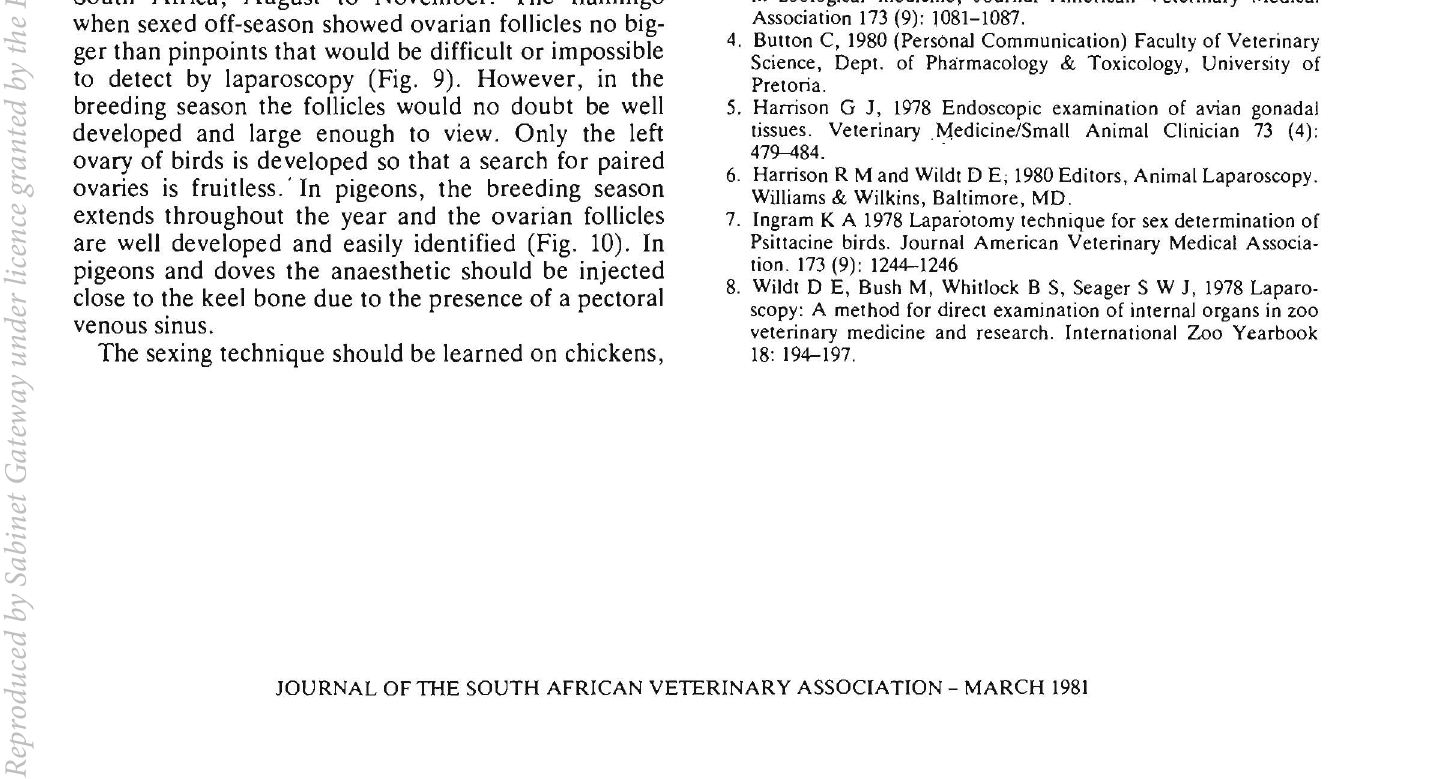
Flg.11 Simple interrupted suture is placed in the skin to close the incision site (Experimental